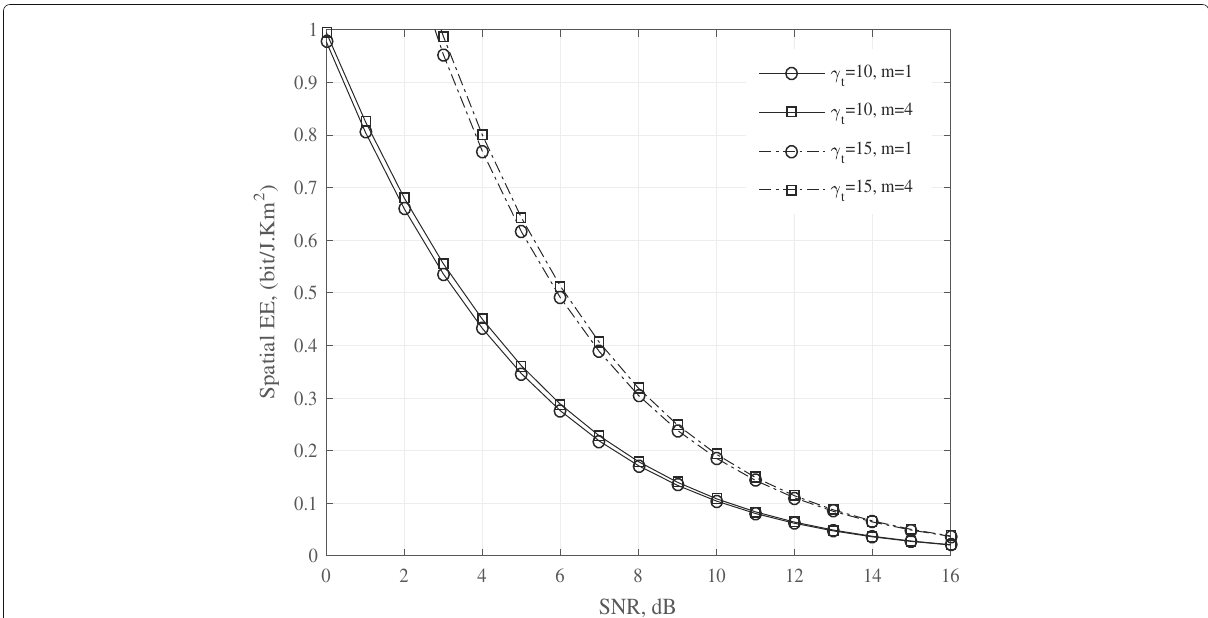
Fig. 10 Spatial energy efficiency in (bit/J.Km 2 ) for single cell as a function of SNR for fading figure m = 1 and 4, SNR threshold γ t = 10 and 15, and path loss exponent α = 4. Spatial EE for, m = 1 and 4, and γ t = 10 and 15